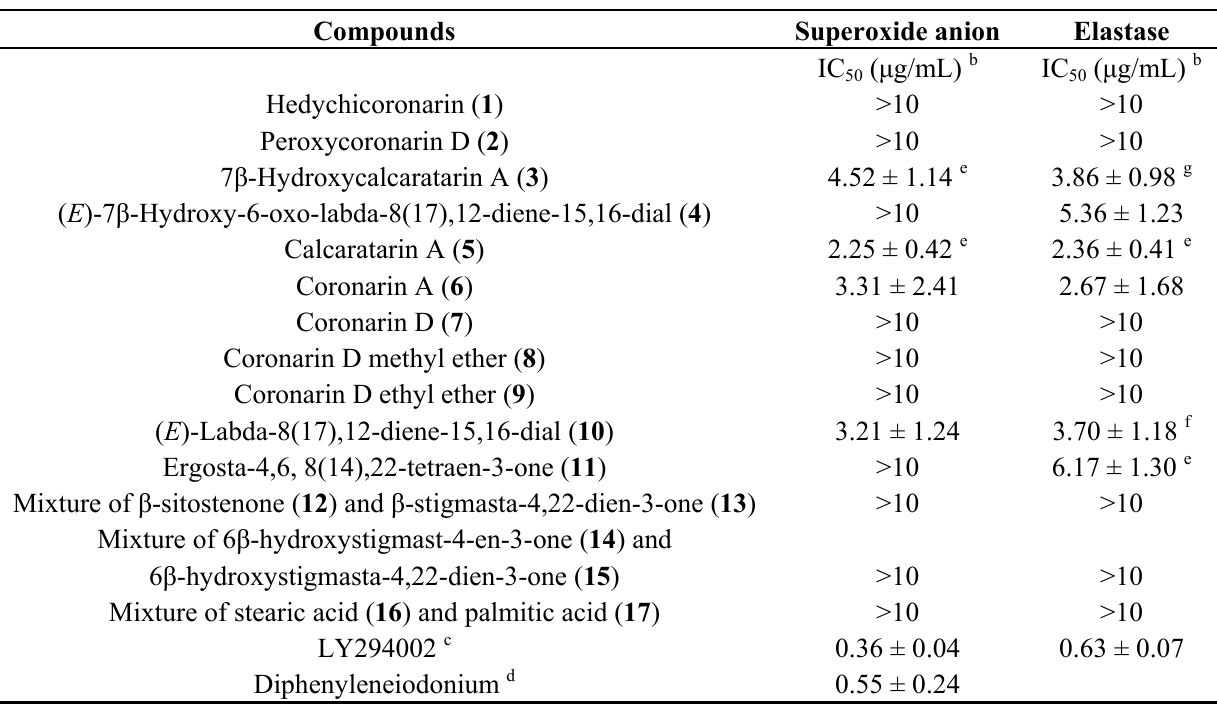
Table 1. Inhibitory effects of compounds 1 – 17 from the rhizome of H . coronarium on superoxide radical anion generation and elastase release by human neutrophils in response to fMet-Leu-Phe/cytochalasin B a